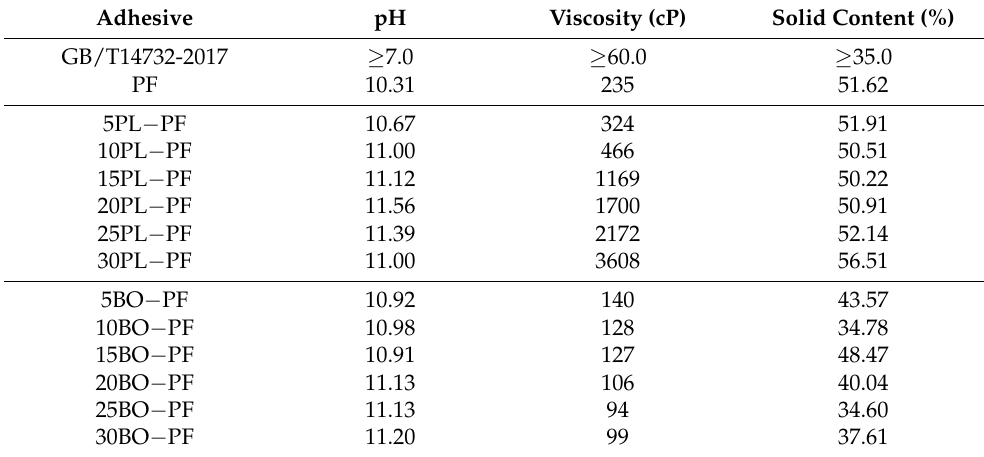
Table 2. The adhesive properties in comparison to the Chinese National Standard (GB/T 14732-2017).